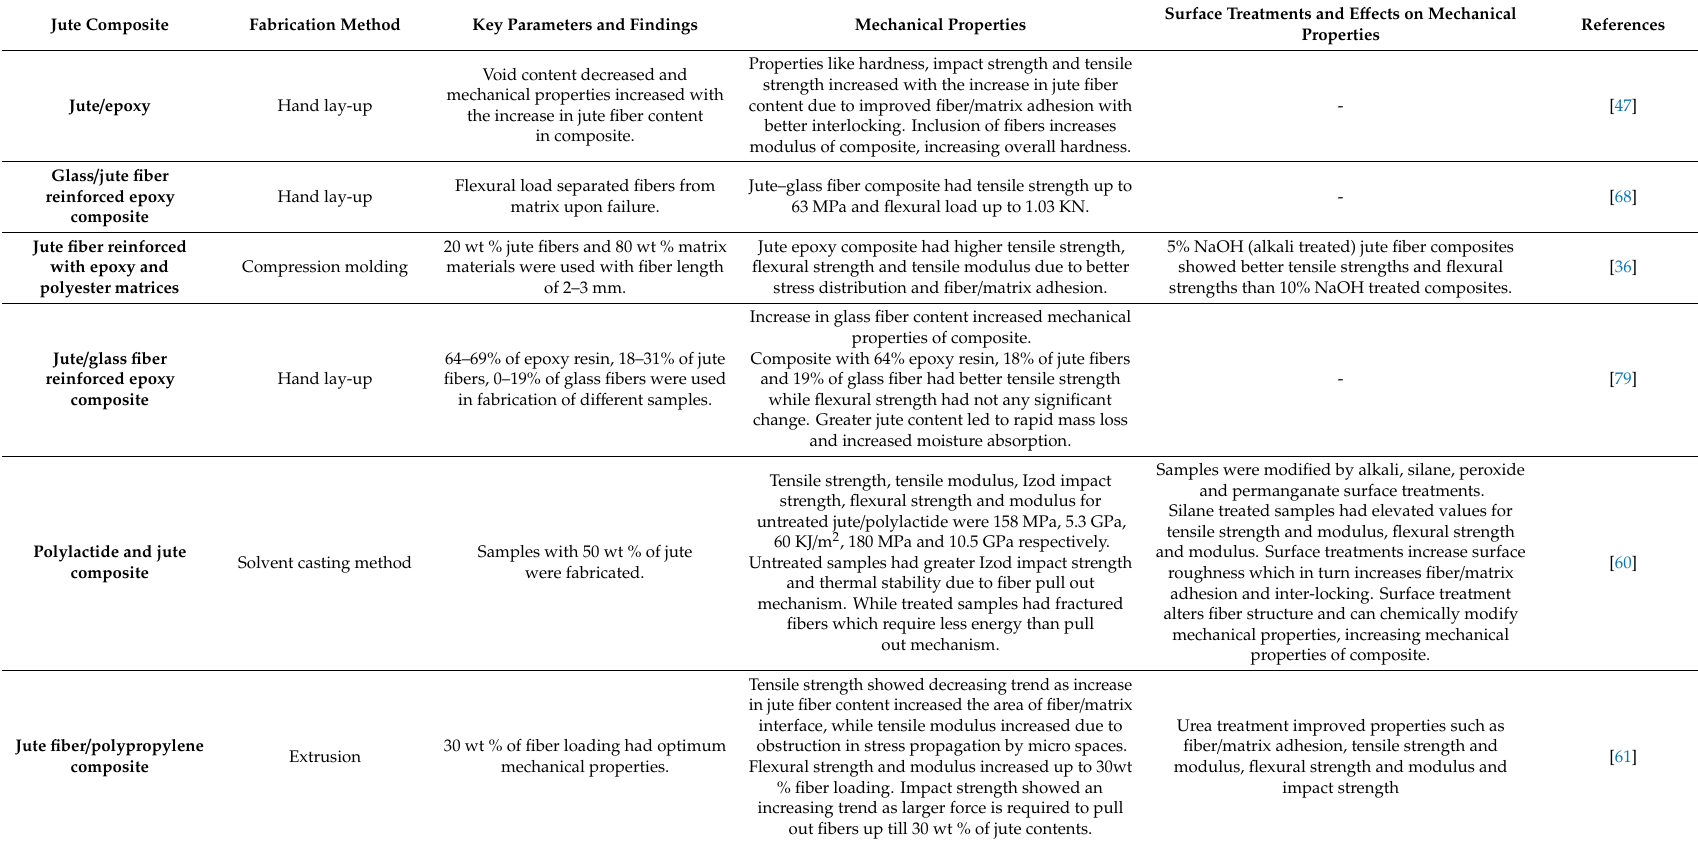
Table 3. Mechanical properties and surface treatments of di ff erent jute-based